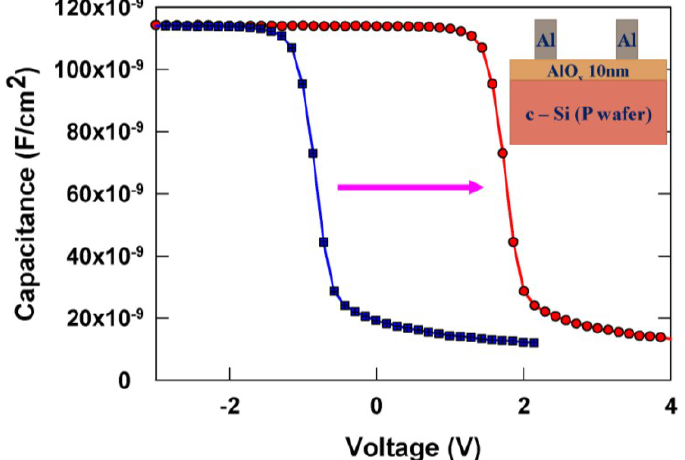
/c-Si capacitance. x